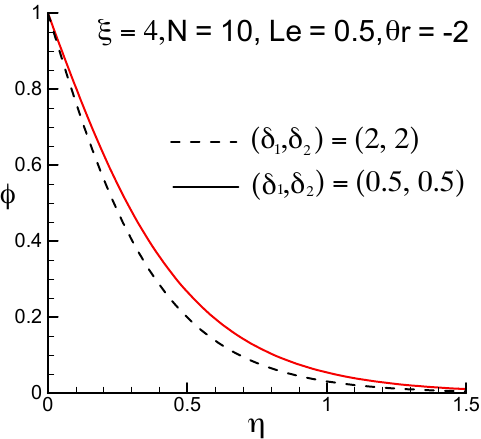
Figure 5. The dimensionless concentration profile for two values of δ 1 and δ 2